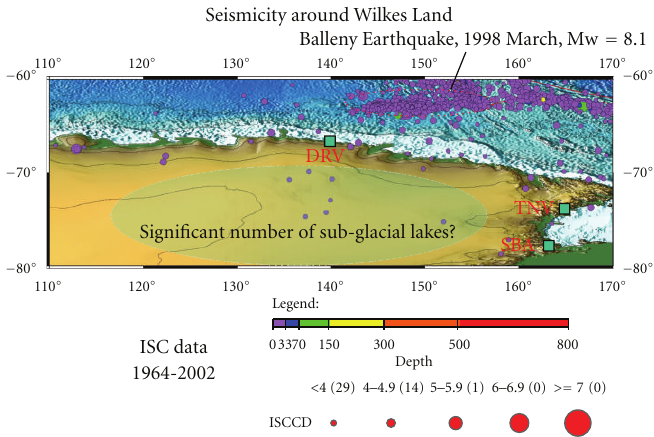
Figure 18: Globally complied seismicity around Wilkes Land, East Antarctica for 1964–2002 by the International Seismological Centre (ISC). The aftershock area of the large Balleny Island Earthquake (1998 March, Mw = 8 . 1) is included on the map in the Antarctic Oceanic Plate. A complexity of the surface bedrock structure might be influenced by tectonically weakened upper crust along with the present mobile belts, forced by the Tasmania microplate. It is also noticed that there is significant a number of subglacial lakes and occurrence of local seismic activities including